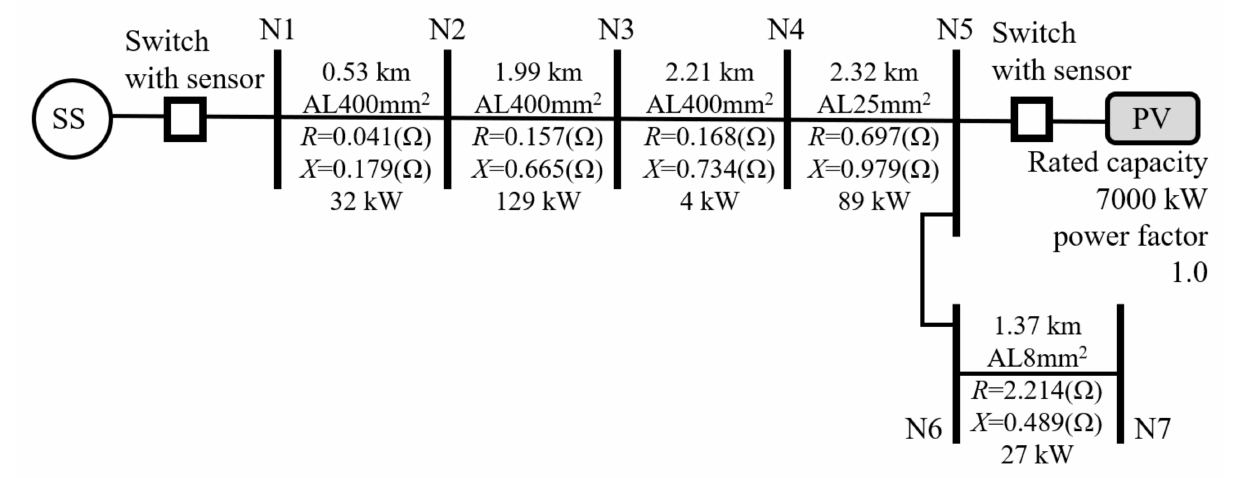
Figure 1. Actual medium voltage feeder with measured unbalanced voltage.